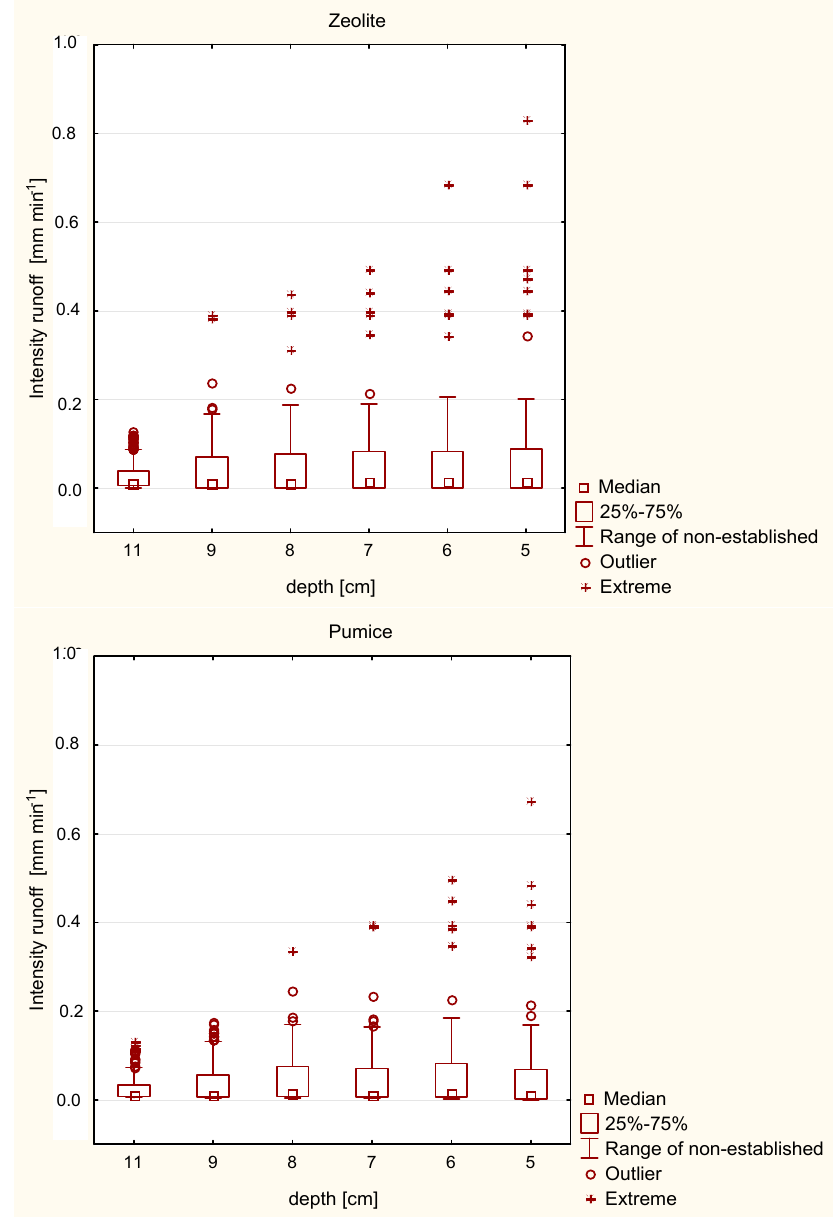
Figure 6. Range of flow rate values at layer depths of 11, 9, 8, 7, 6 and 5 cm in extensive roof models on 28 July 2017 at Wroc ł aw Swojec.